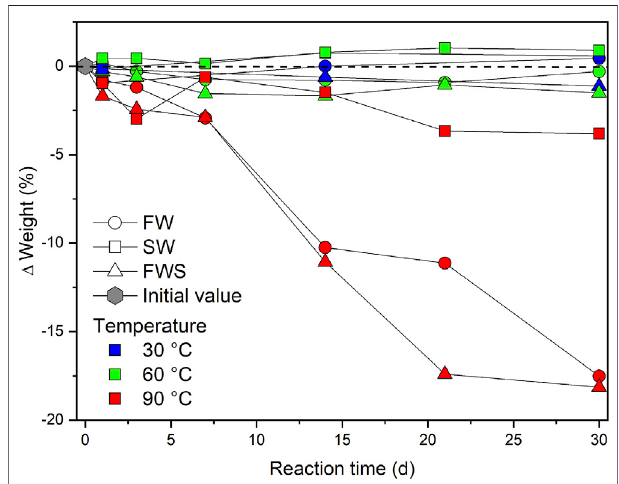
FIGURE 3 | Weight loss over time expressed as difference in percent from the initial weight. Zero on the y -axis represents the respective initial weight. Values below or above the dashed reference line re fl ect a decrease or increase in weight, respectively. Error bars are smaller than the